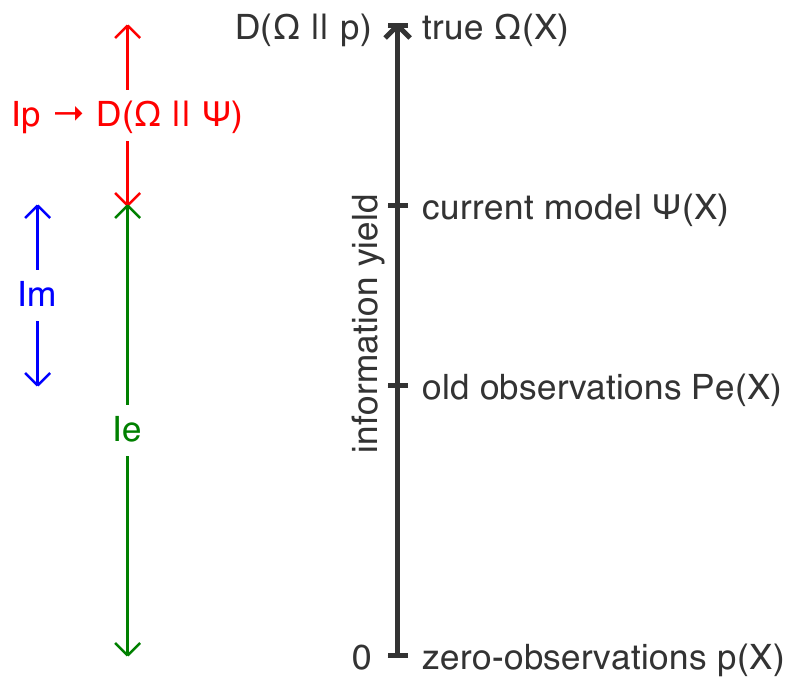
Colored intervals